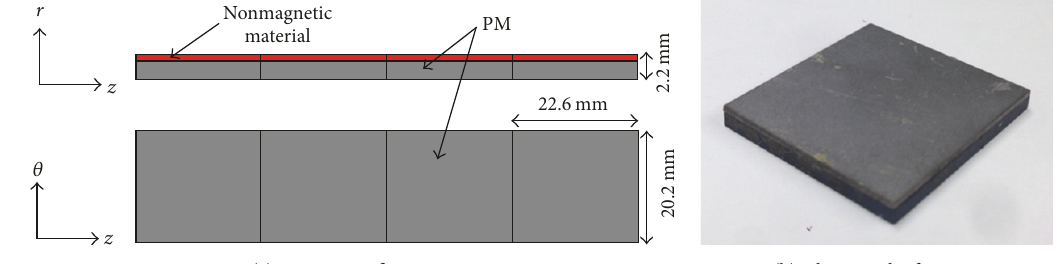
Figure 2: PMs for radial